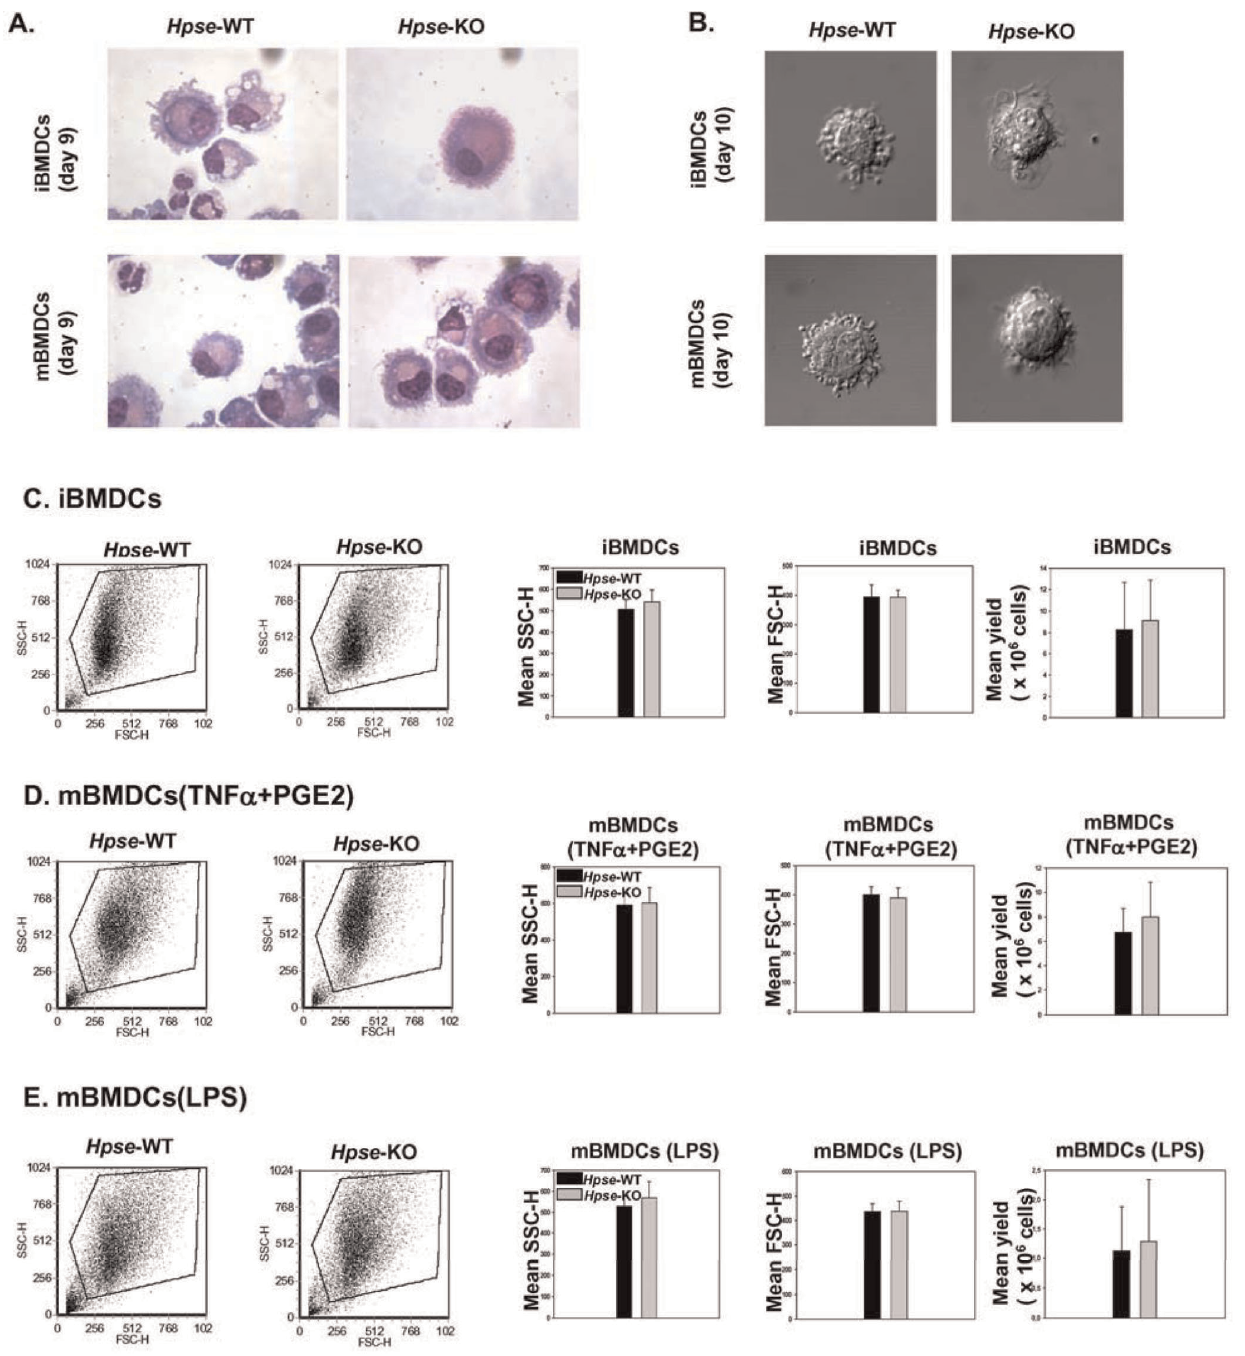
Figure 2. Morphologic parameters of iBMDCs and mBMDCs are comparable in Hpse -WT and Hpse -KO mice. A . Wright staining of BMDCs from Hpse- WT and Hpse -KO mice. B . Nomarsky view via confocal microscopy of BMDCs from Hpse- WT and Hpse -KO mice (zoom 60 6 5, Olympus IX70, Center Valley, PA). C . Representative dot plot analysis of side scatter (SSCH) and forward scatter (FSCH), and yield of iBMDCs. Average from five experiments. D and E . The same for mBMDCs, matured with mTNF a + PGE2 ( D ), or LPS ( E